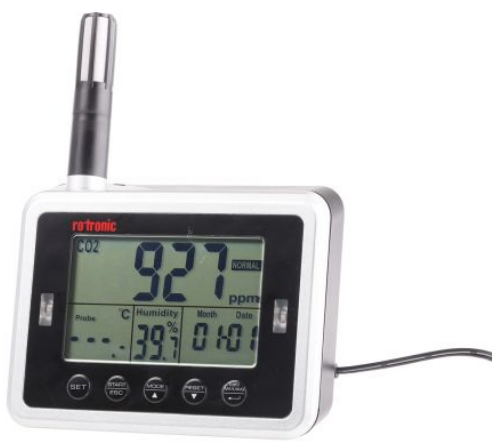
Figure 2. Benchtop display data logger rotronic CL11 unit. Table 2. Data from the data logger and the measurement